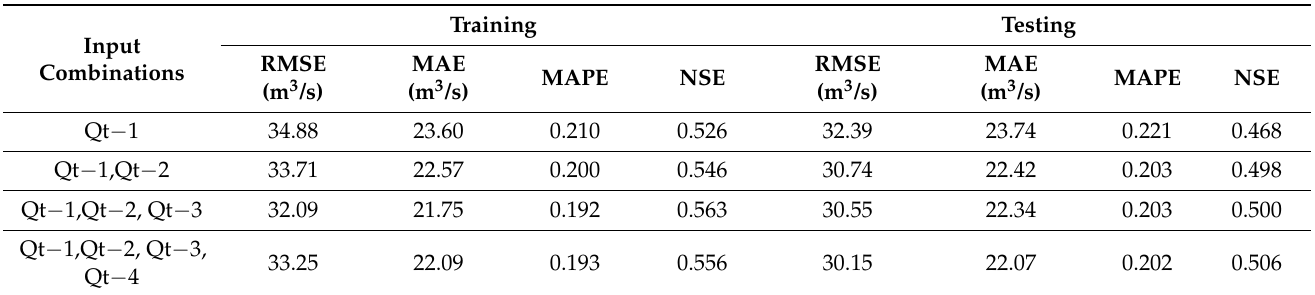
Table 6. Training and testing statistics of the MARS models using different input combinations in estimating daily streamflow of Skallbole Station (downstream) using data from Ostavallselet Station (upstream).